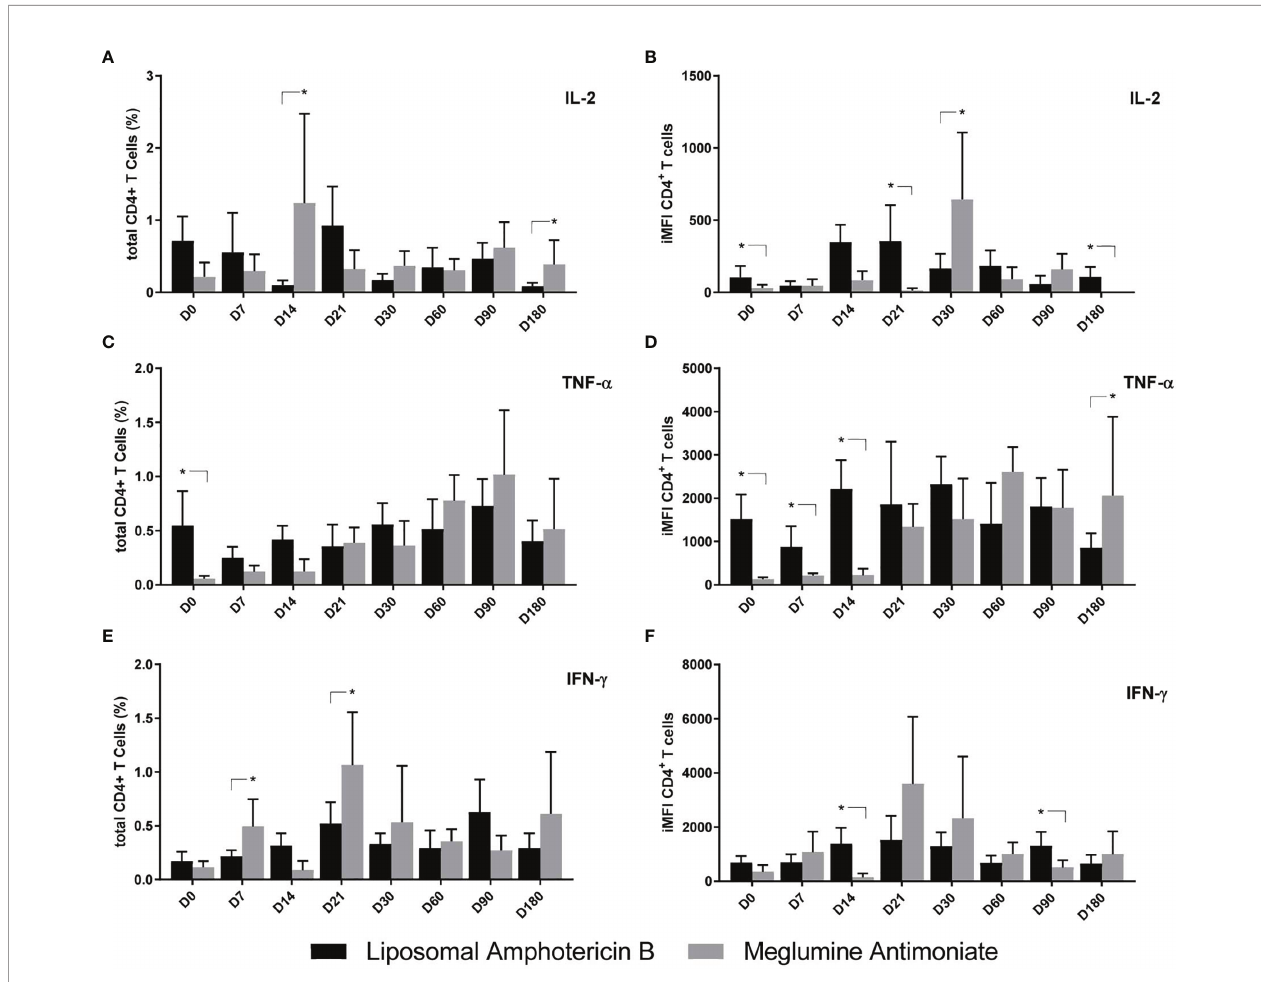
FIGURE 7 | Cytokine production by CD4 + T cells of patients treated with meglumine antimoniate (Glucantime ® ) and amphotericin B Frequency (A – C) and integrated mean fl uorescence intensity (iMFI) (D – F) of T CD4 cells producing IL-2, TNF- a , and IFN- g from patients treated with Glucantime ® (N = 8) and amphotericin B (N = 5). The frequencies and iMFI of each cytokine expressing phenotype were recorded after background subtraction of cells incubated without antigen [soluble Leishmania antigen (SLA)]. Results in the panel are expressed as means+SE. Asterisks and horizontal lines indicate statistical differences between treatments as disclosed by